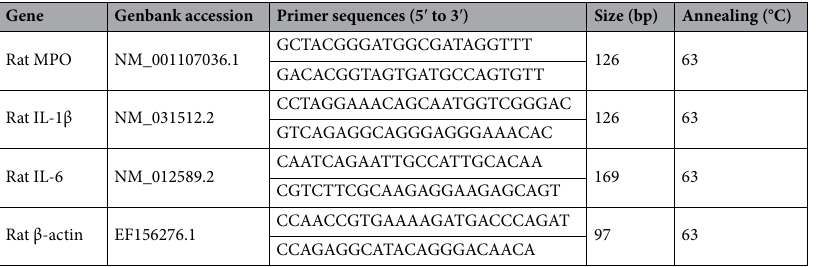
Table 1. The oligonucleotide primers used for PCR